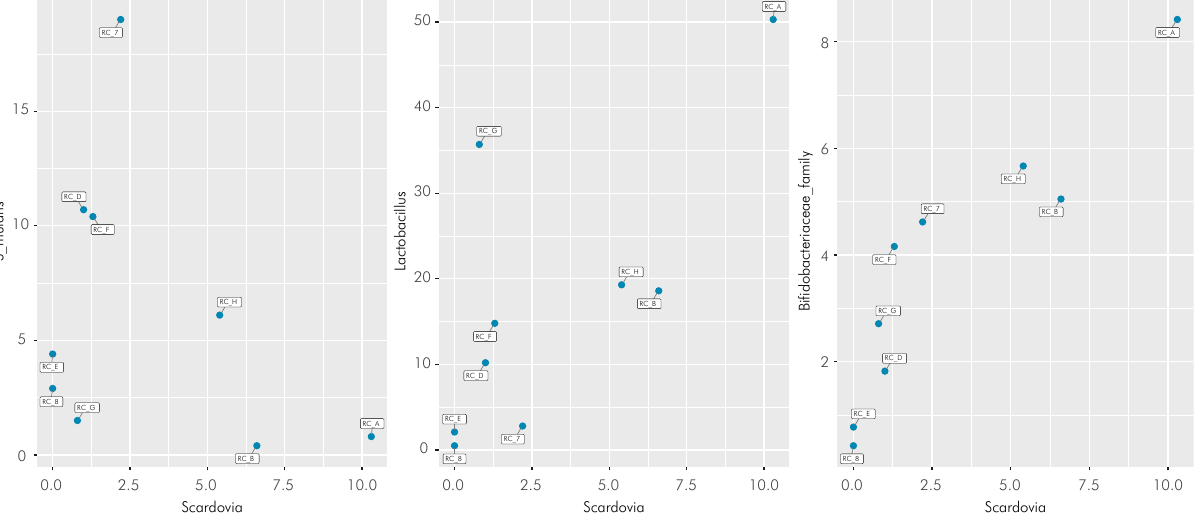
Figure 3. Correlation analysis of relative prevalence (% in the total metatranscriptome) of Scardovia and other cariogenic species. (pipeline a). A: Streptococcus mutans proportion within the total metatranscriptome; B: Lactobacillus species proportion within the total metatranscriptome; C: Bifidobacteriaceae family proportion within the total metatranscriptome. Each point represents each sample (RC: Root